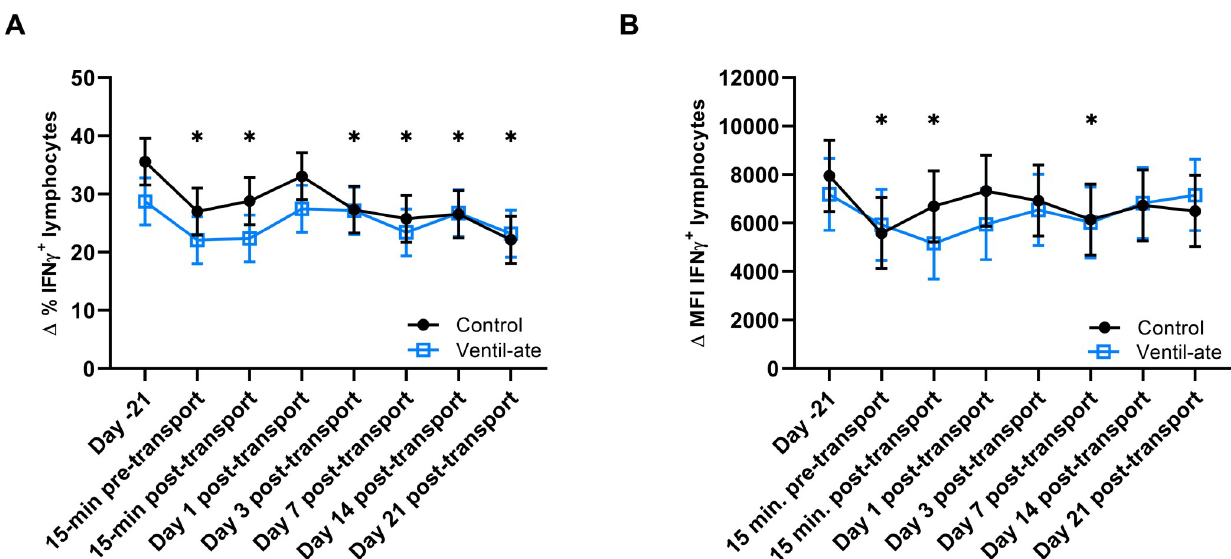
Fig 6. Change ( Δ ) in the (A) percentage (%) and (B) mean fluorescence intensity (MFI; geometric mean) of IFN γ + lymphocytes after stimulation and with media values included as a covariate. For illustrative purposes, the figure displays results (least squares means ± SE) from the analyses that included the group-by-time interaction; however, the significant differences shown were determined from the analyses with only group and time included as main effects. (A–B) Significant time effects were observed ( P = 0.0016 and P = 0.0039, respectively). � denotes a significant difference from baseline (Day –21). IFN γ , interferon